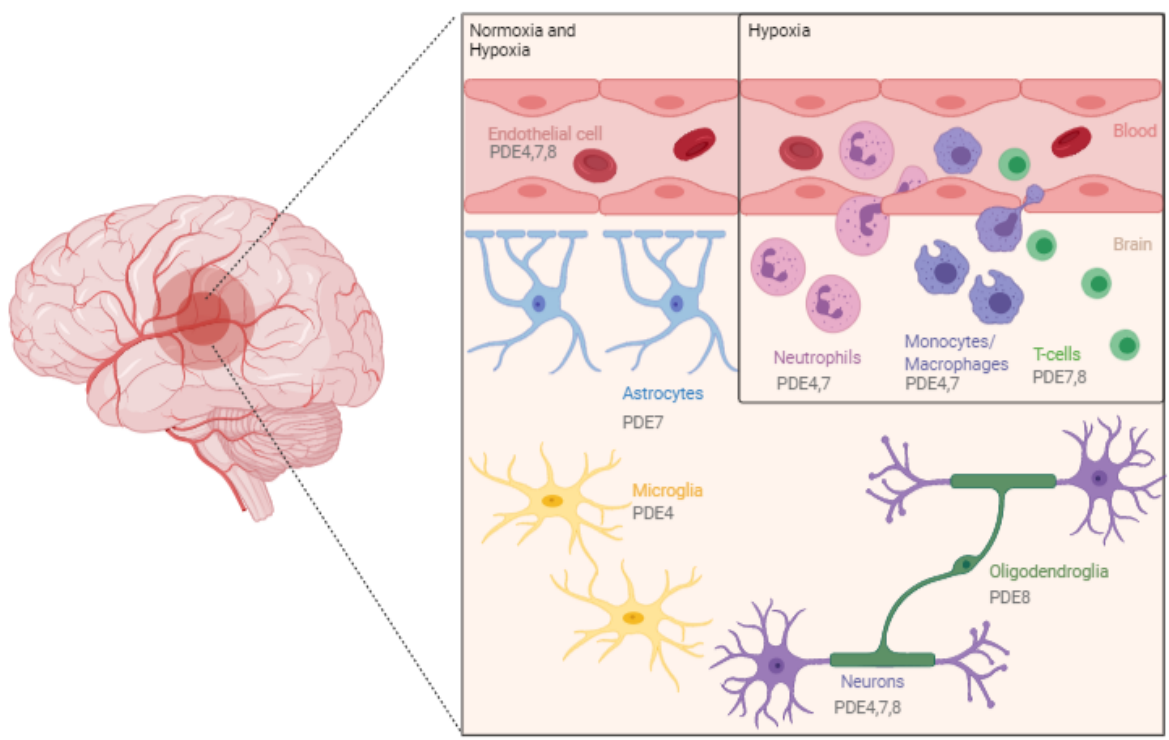
Figure 2. Overview of the most important cell types involved in the neuroinflammatory reaction of ischemic stroke pathophysiology and their expression of cAMP-specific phosphodiesterases (PDEs). Endothelial cells and neurons are found to express PDE4, 7, and 8, while astrocytes only express PDE7 and oligodendrocytes PDE8. PDE4 and 7 are both found in native immune cells, such as neutrophils and monocytes/macrophages, while T cells express PDE7 and 8. Microglia, which are considered the resident immune cells of the brain, possess PDE4. Figure created with biorender.com (accessed on 1 May